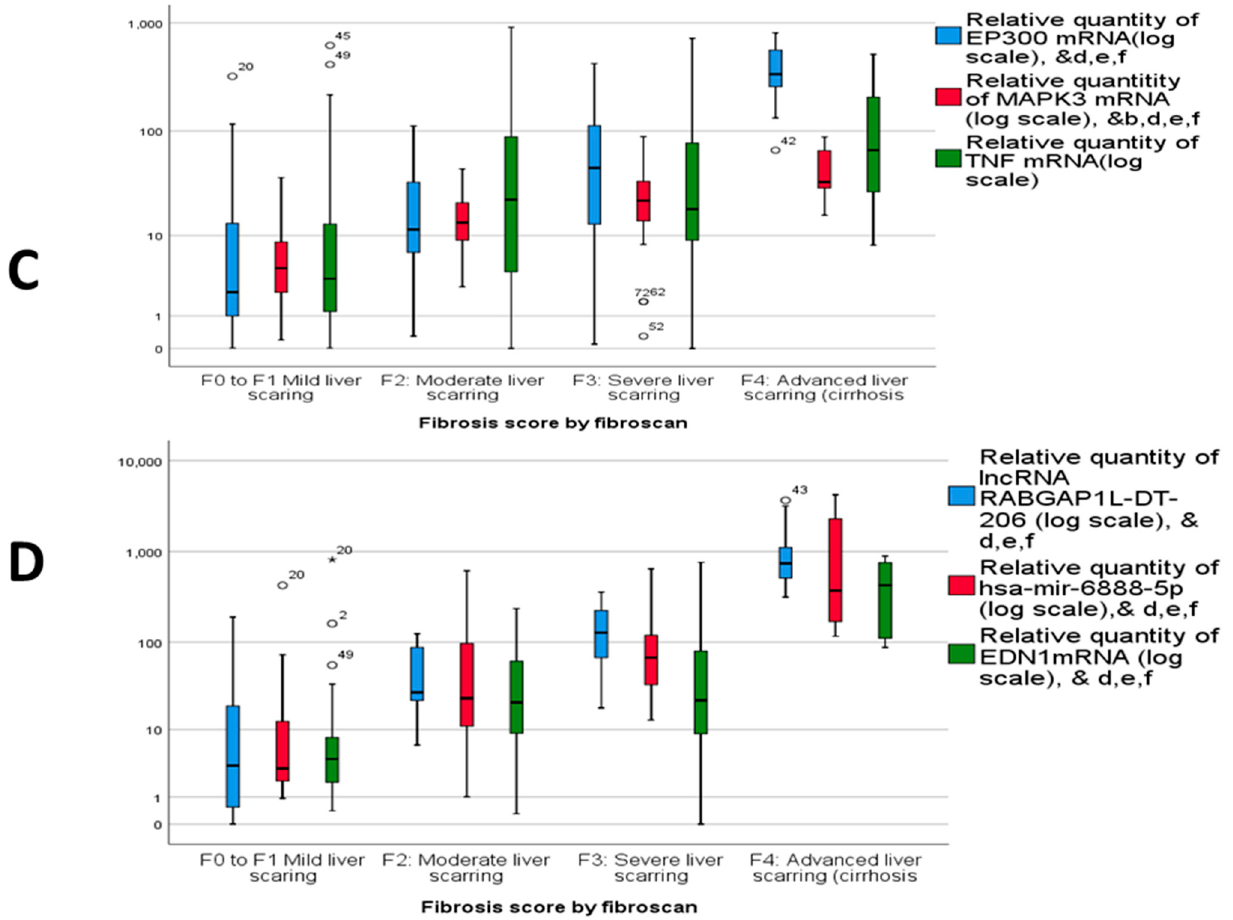
Figure 4. Relative expression of circulatory RNA panel among different NAFLD scores of ( A ) lncRNA RABGAP1L-DT-206, hsa-miR-6888-5p and EDN1 mRNA; ( B ) TNF mRNA, MAPK3 mRNA, and EP300 mRNA and statistically significant difference ( p < 0.05) by Tukey post hoc test, a, b NAFLD score 1 vs. 3, c NAFLD score 2 vs. 3. ( C ) Relative expression among different fibrosis scores of TNF mRNA, MAPK3 mRNA, and EP300 mRNA , and ( D ) relative expression among different fibrosis scores of lncRNA RABGAP1L-DT-206, hsa-miR-6888-5p, and EDN1 mRNA and statistically significant difference by post Hoc (Turkey) test. & statistically significant difference ( p < 0.05) by Tukey post-hoc test, b Fibrosis stage 2 vs. Fibrosis stage 3, c Fibrosis stage 1 vs. Fibrosis stage 3, d Fibrosis stage 1 vs. Fibrosis stage 4, e Fibrosis stage 2 vs. Fibrosis stage 4, f Fibrosis stage 3 vs. Fibrosis stage 4. Table 3. Multivariate regression